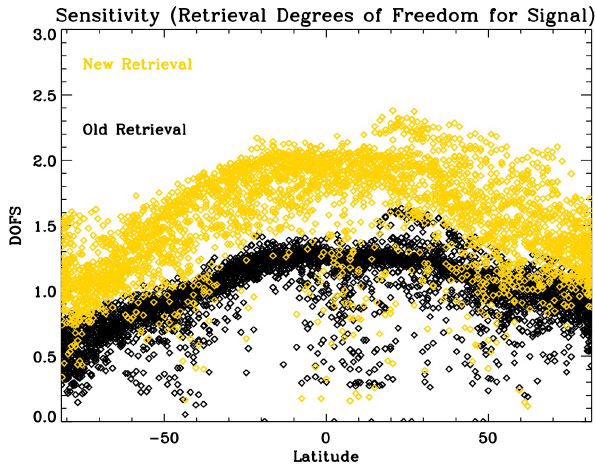
Fig. 8. DOFS for the new methane retrieval (yellow) and the old methane retrieval (black).